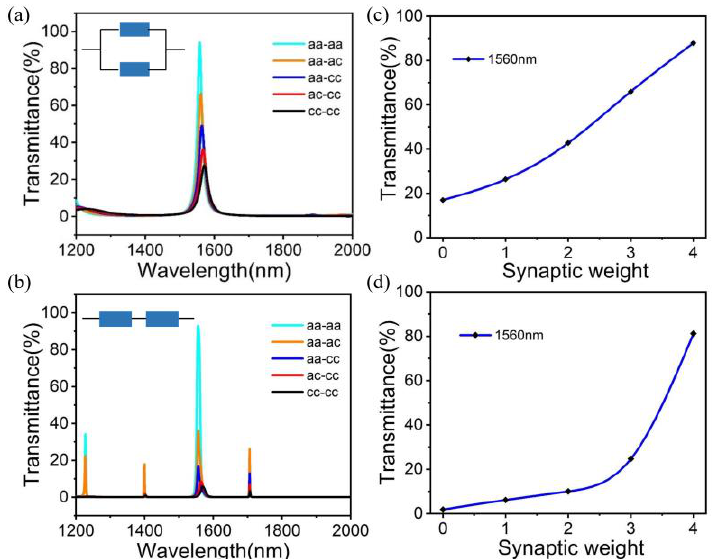
Figure 7. ( a , b ) The relationship between GST crystallization rate and transmission peak intensity at photonic synapse series and parallel. ( c , d ) The transmittance corresponding to the synaptic weights (0, 1, 2, 3, 4) at the wavelength of 1560 nm.